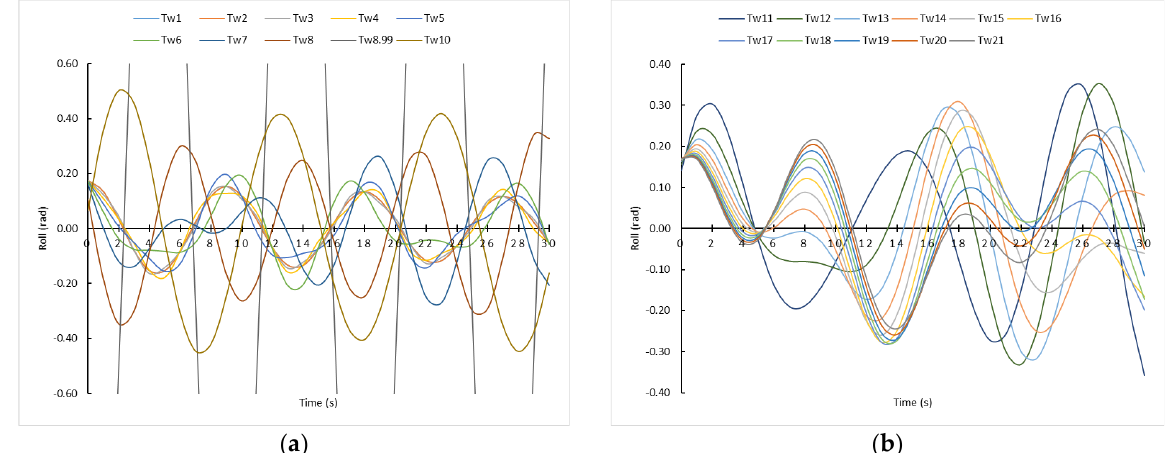
Figure 2. Rolling motion induced by pure beam seas with resistance and with the ship in static condition. ( a ) Tw from 1 s to 10 s. ( b ) Tw from 11 s to 21 s.